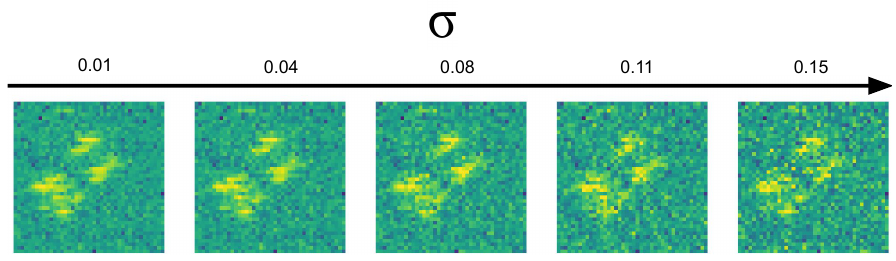
Figure 7. Speckle noise data augmentation.